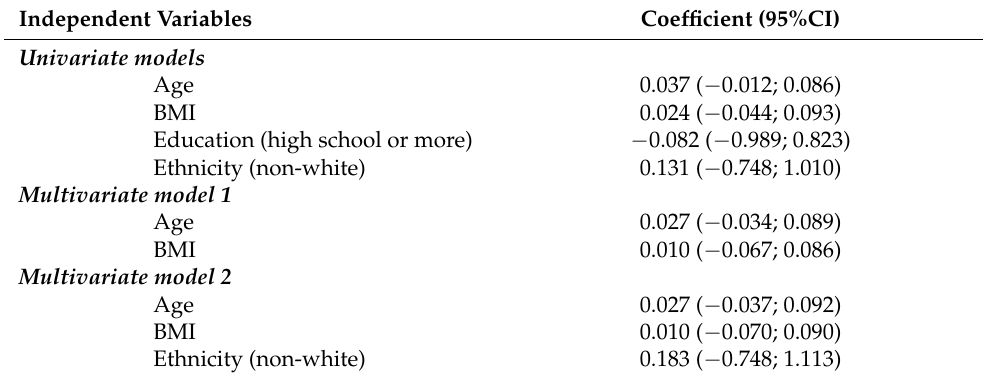
Table 6. Regression analyses of the association between umbilical blood levels of Σ DDT and birth outcomes.